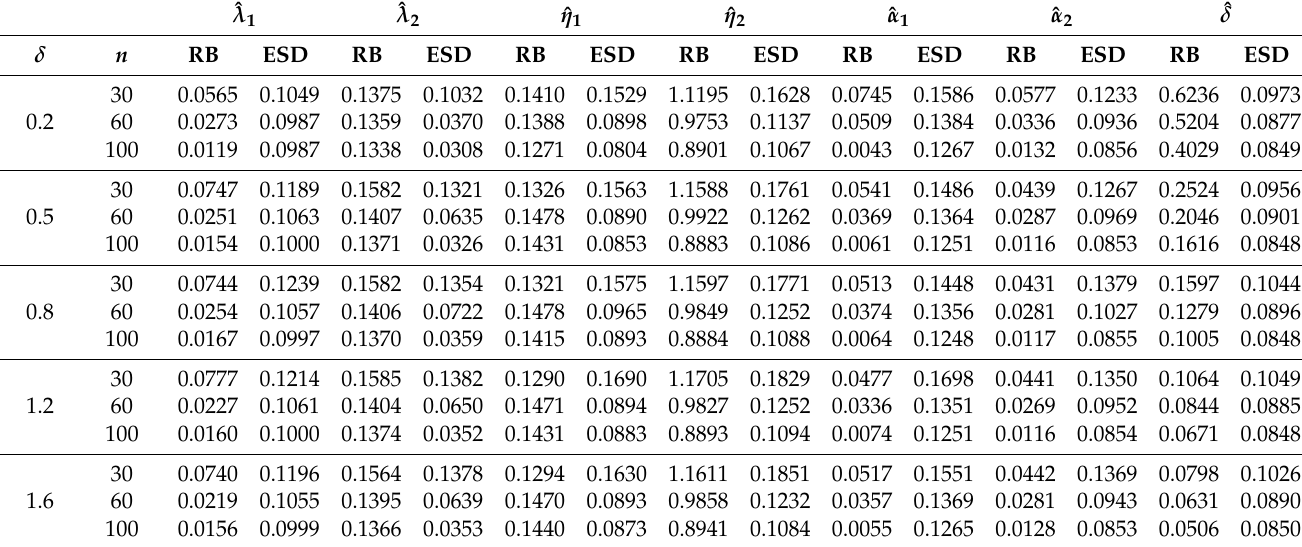
Table 1. RB and ESD for the BSHPN